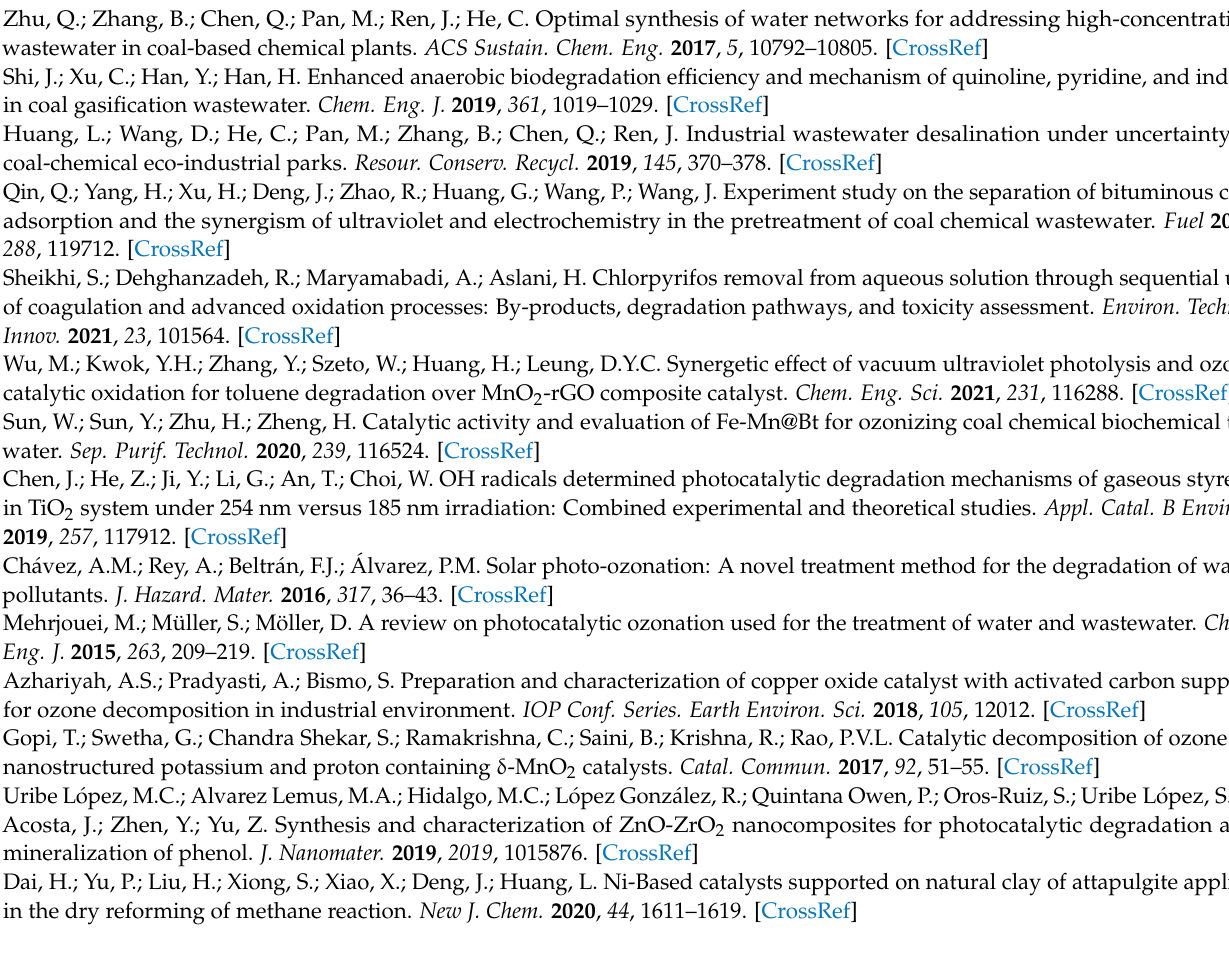
Table S7: Summary of experimental data. Table S8: Experimental data standardization. Table S9: Cor- relation coefficient matrix. Table S10: Index characteristic values and variance explanation rate. Table S11: Principal component load coefficients. Table S12: Comprehensive score coefficients of principal components. Table S13: BET characterization results of catalysts. Table S14: Ranking